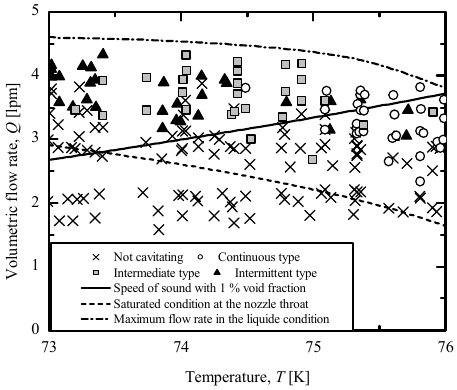
Fig. 4 Enlarged view of the distribution between 73 K and 76 K shown in Fig.